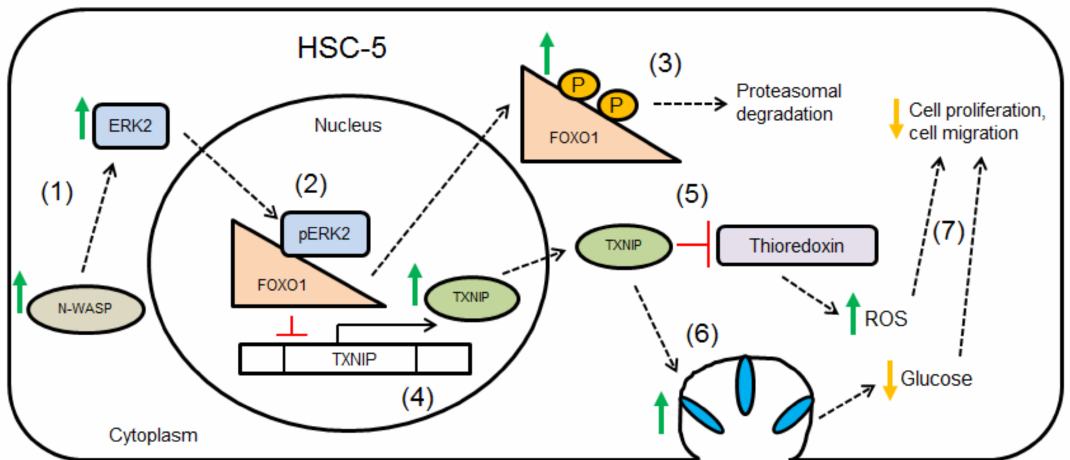
Figure 7. Proposed model for N-WASP-mediated suppression of cell proliferation. ( 1 ) Increased N-WASP levels enhance ERK2 phosphorylation. ( 2 ) Active ERK2 translocates from the cytoplasm to the nucleus and causes FOXO1 phosphorylation. ( 3 ) Phosphorylated FOXO1 translocates from the nucleus to the cytoplasm and is degraded by the proteasome. ( 4 ) Inhibition of TXNIP expression is relieved. ( 5 ) TXNIP inhibits the thioredoxin system, causing ROS accumulation. ( 6 ) TXNIP promotes GLUT1 endocytosis, reducing cellular glucose uptake. ( 7 ) Changes in ROS levels, glucose levels and activities of molecular effectors lead to decreased cell proliferation and migration.